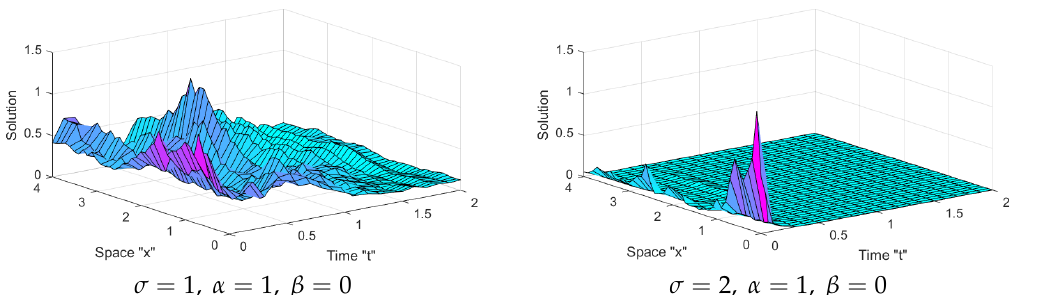
Figure 2. A 3D-plot of the solution ϕ ( x , t ) in Equation (25) for σ =